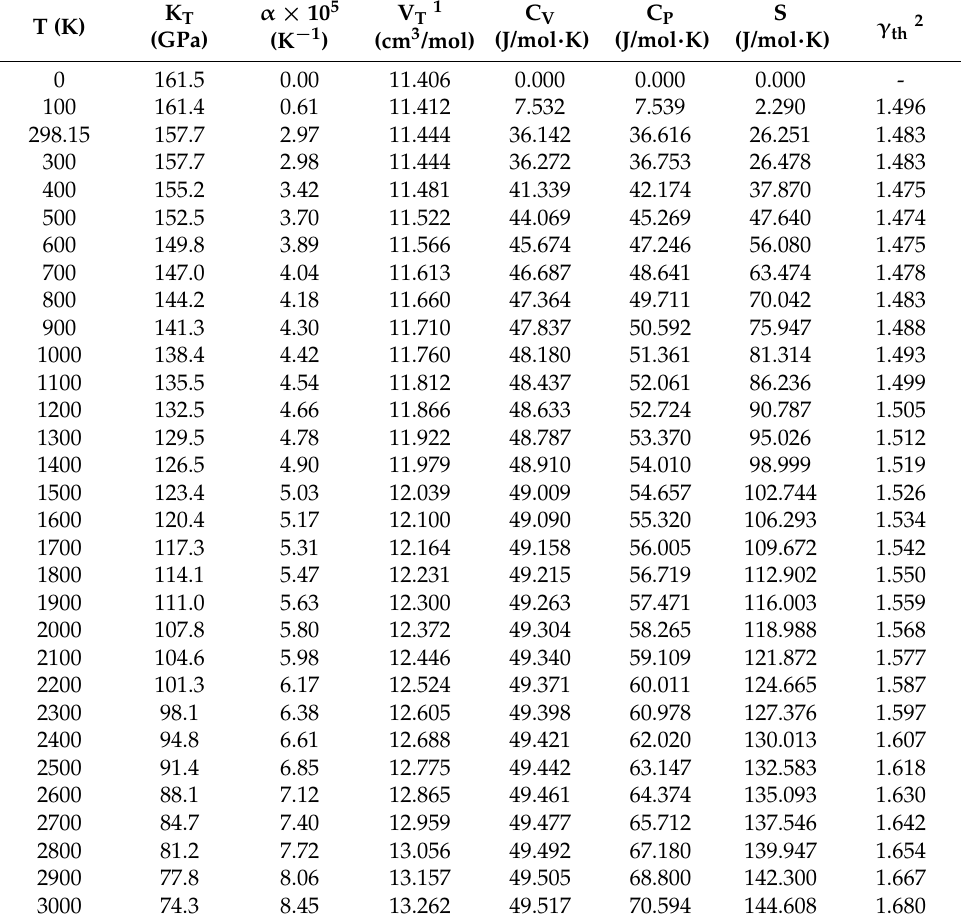
Table A1. Ab initio B3LYP thermophysical and thermodynamic functions of MgO at P = 1 bar, T = 298.15–3000 K. Symbols: K T = isothermal bulk modulus; α = thermal expansion coefficient (thermal expansivity); V T = molar volume; C V , C P = isochoric and isobaric heat capacity; S = entropy; γ th = Grüneisen thermodynamic